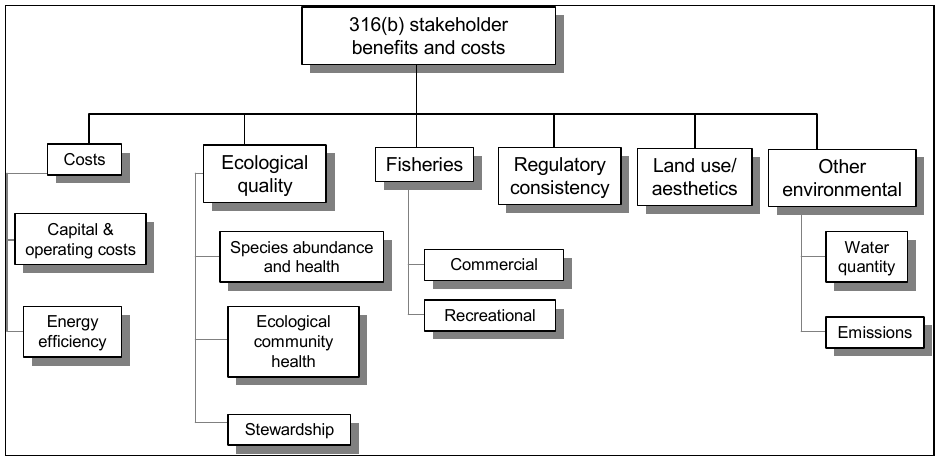
FIGURE 1. Stakeholder values relevant to most 316(b) decisions. Graphical organization does not indicate any priority. Measurement criteria are required for all categories and may differ for different 316(b)